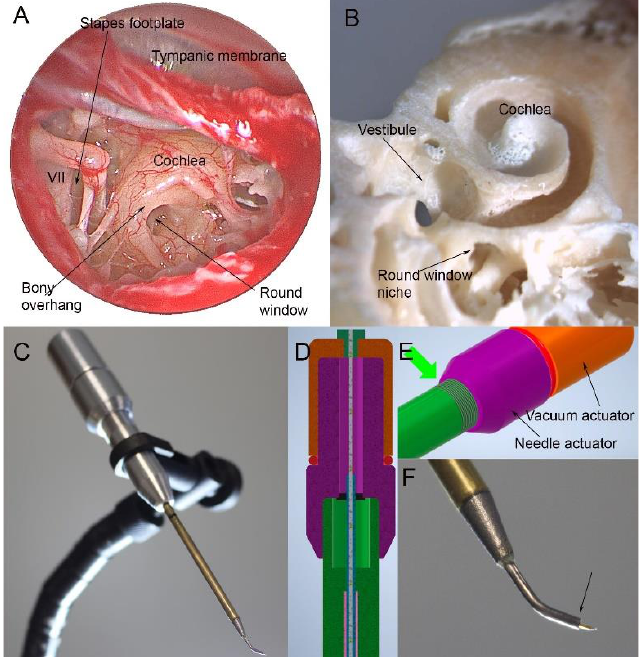
Figure 1. Endoscopic view of the right human middle ear ( A ). After lifting the tympanic membrane, the round window can be seen but is partially obscured by a bony overhang. Only a small area of the stapes footplate is visible next to the facial nerve (VII), making it difficult to access. The anatomy of the cochlea can be seen in a human temporal bone in which the cochlea has been opened ( B ). The round window niche allows access to the basal turn of the cochlea. A prototype sampling device features a 56 mm long shaft that can be passed down the ear canal to reach the round window ( C ). The device has two internal actuators, one advancing a needle and one allowing a plunger to be withdrawn from the needle/internal reservoir ( D , E ) through threading built into the device (green arrow, ( E )). This allows advancement of a needle from the curved tip of the device in submillimeter increments and withdrawal of up to 10 µL of fluid. The tip of the device is shown in ( F ) and measures 0.86 mm at the tip (arrow) from which the needle is deployed.